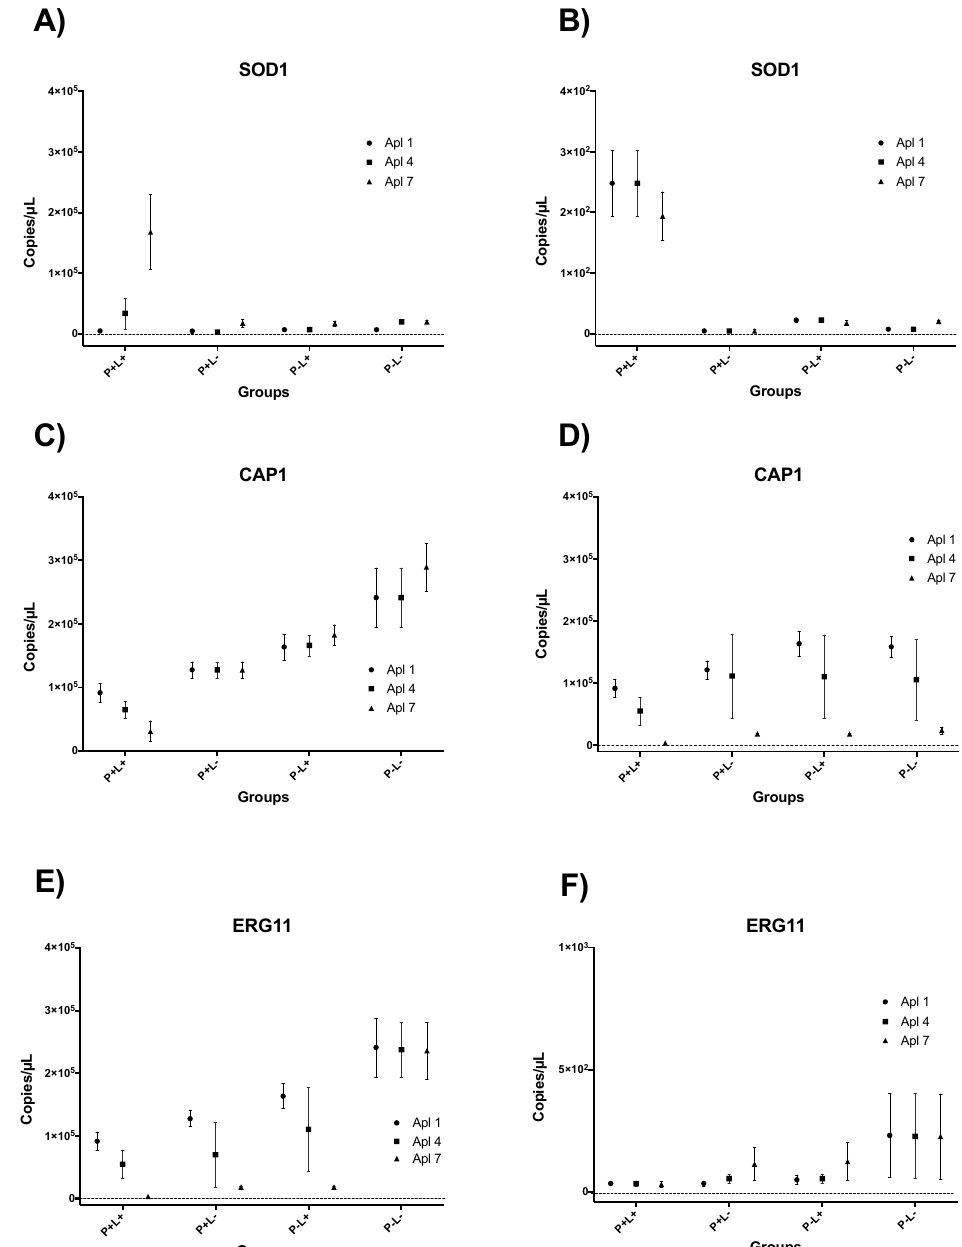
Figure 12. Graphic representation of mean ± confidence interval of 95% of SOD1 ( A , B ), CAP1 ( C , D ), and ERG11 ( E , F ) gene expression in each experimental group of C. albicans cells removed from biofilm cultured in SDA without ( A , C , E ) and with ( B , D , F ) fluconazole after first (Apl#1), fourth (Apl#4) and seventh (Apl#7) application of PDZ-mediated aPDT (P+L+), PS control (P+L − ), light control (P − L+), and experiment control group (P − L − ). Minimum and maximum values of the copies/ µ L error bar represent the lower and upper limits of the confidence interval, respectively. The non-intersection of error bars denotes statistical difference ( p < 0.05).